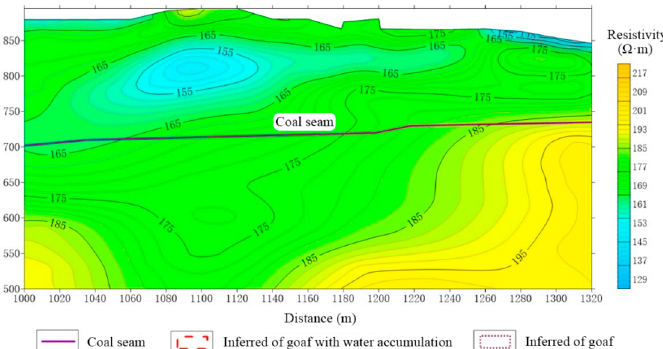
Figure 6. Apparent Resistivity Cross-Sectional Diagram of Survey Line L2 Obtained Through CSAMT-based 2D Profile Inversion.